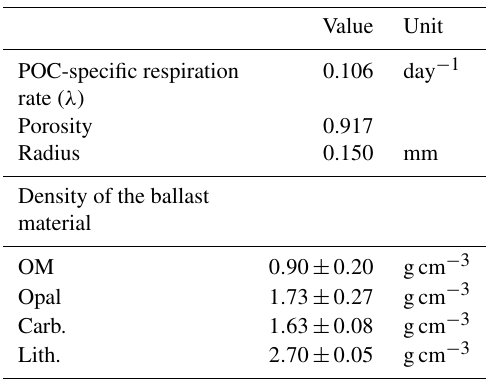
Table 6. Values used to calculate sinking speeds (Eqs. 6–9). Densi- ties of the bulk components were obtained from the